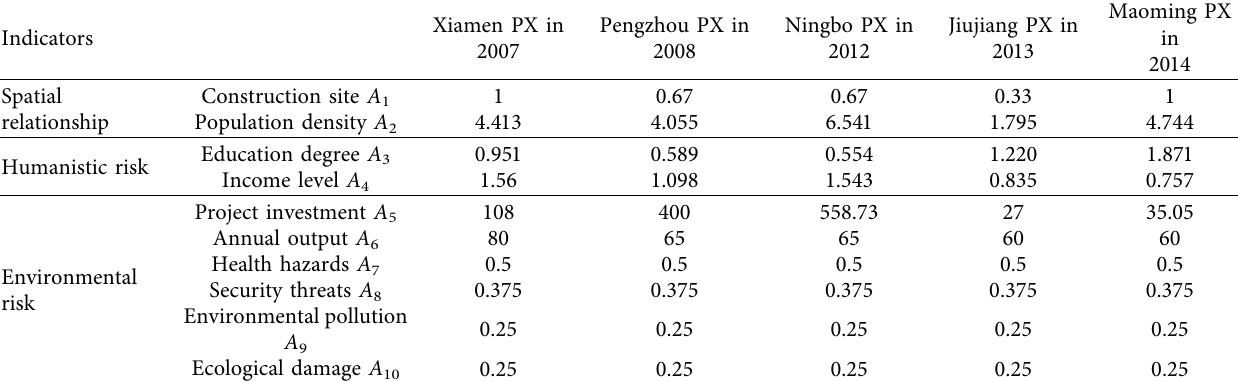
Table 2: Relevant data of five PX projects.